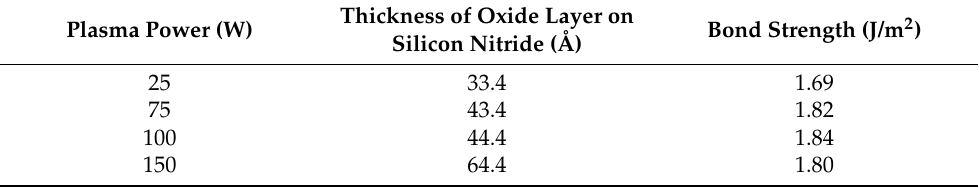
Table 2. Bond strength and thickness of the oxide layer under various plasma power conditions. Thickness of Oxide Layer on Plasma Power (W)